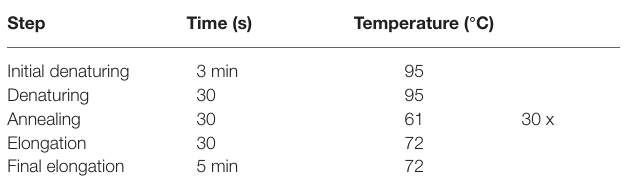
TABLE 2 | PCR program for amplification of Tribolium castaneum and Locusta migratoria crlf3